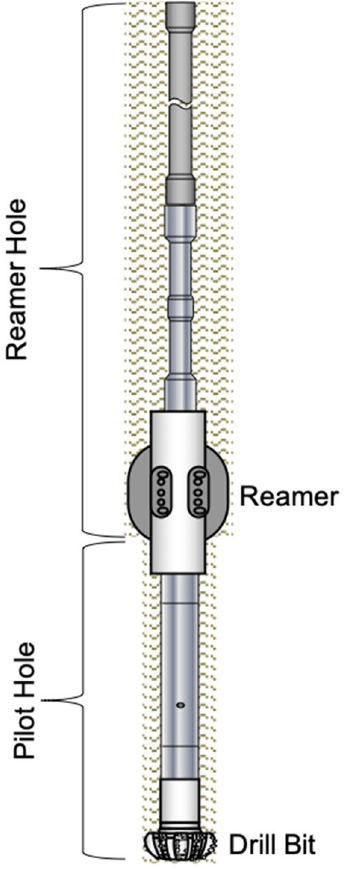
Fig. 1 Simultaneous drilling and reaming with pilot